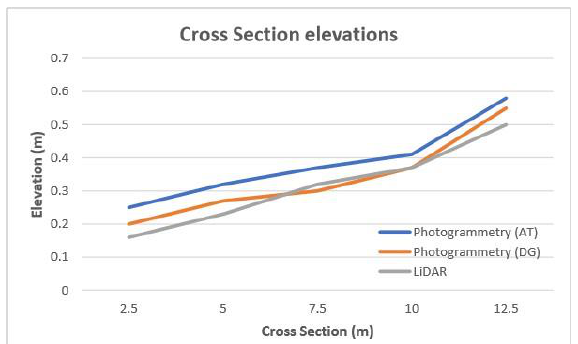
Figure 4: DTM profiles in comparison (AT blue, DG orange and LiDAR